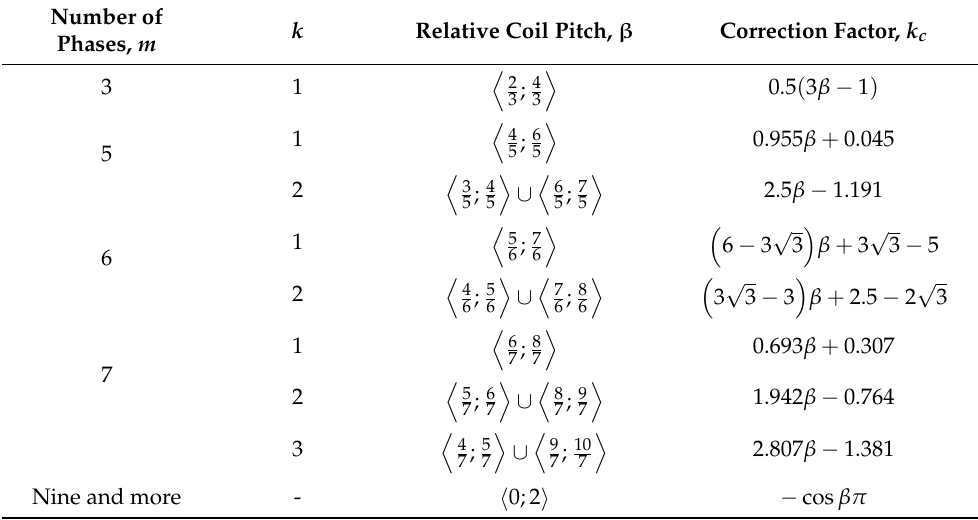
Table 2. Summarized correction factor k c for different numbers of phases and coefficient k